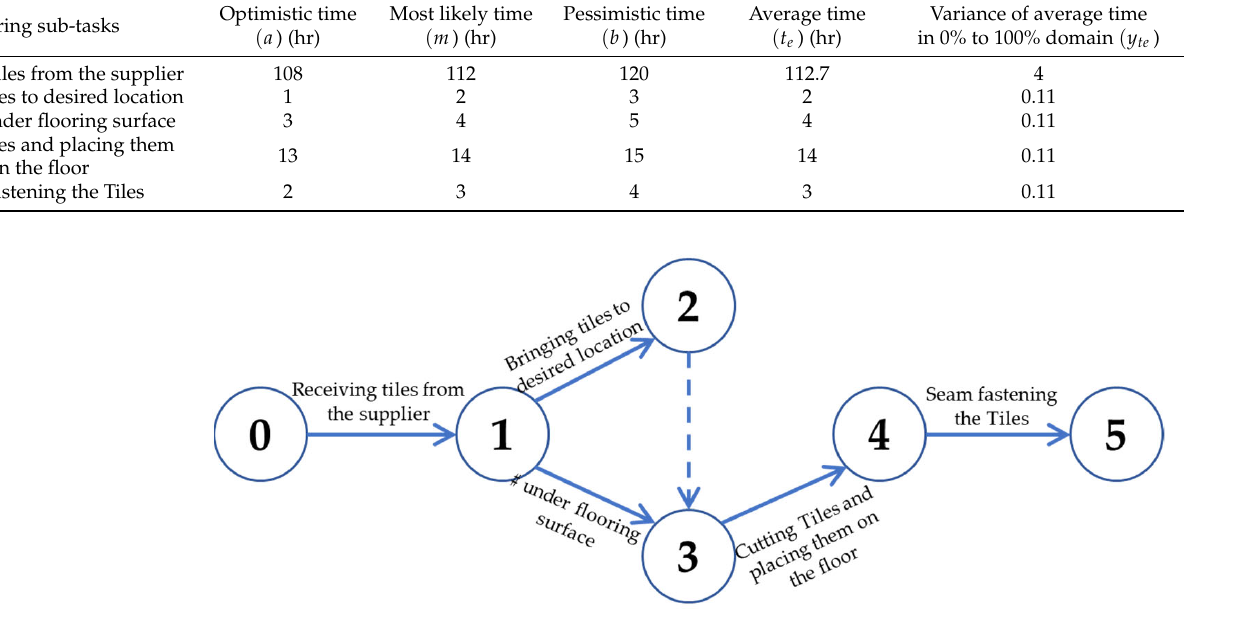
Figure 11. AOA system for sub-tasks of flooring.